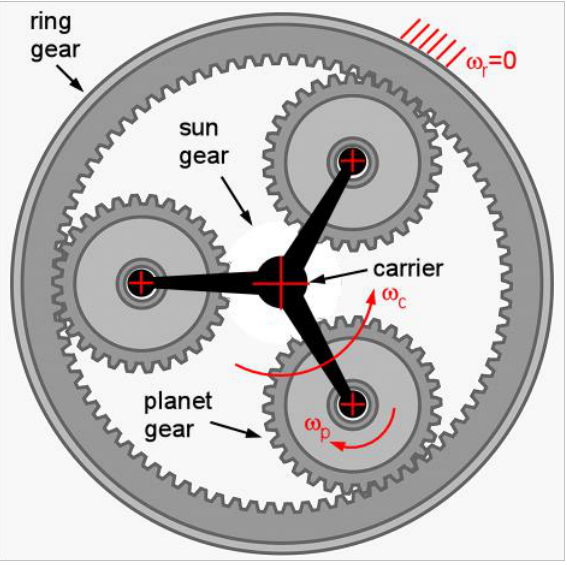
Figure 8. Planetary mechanism.